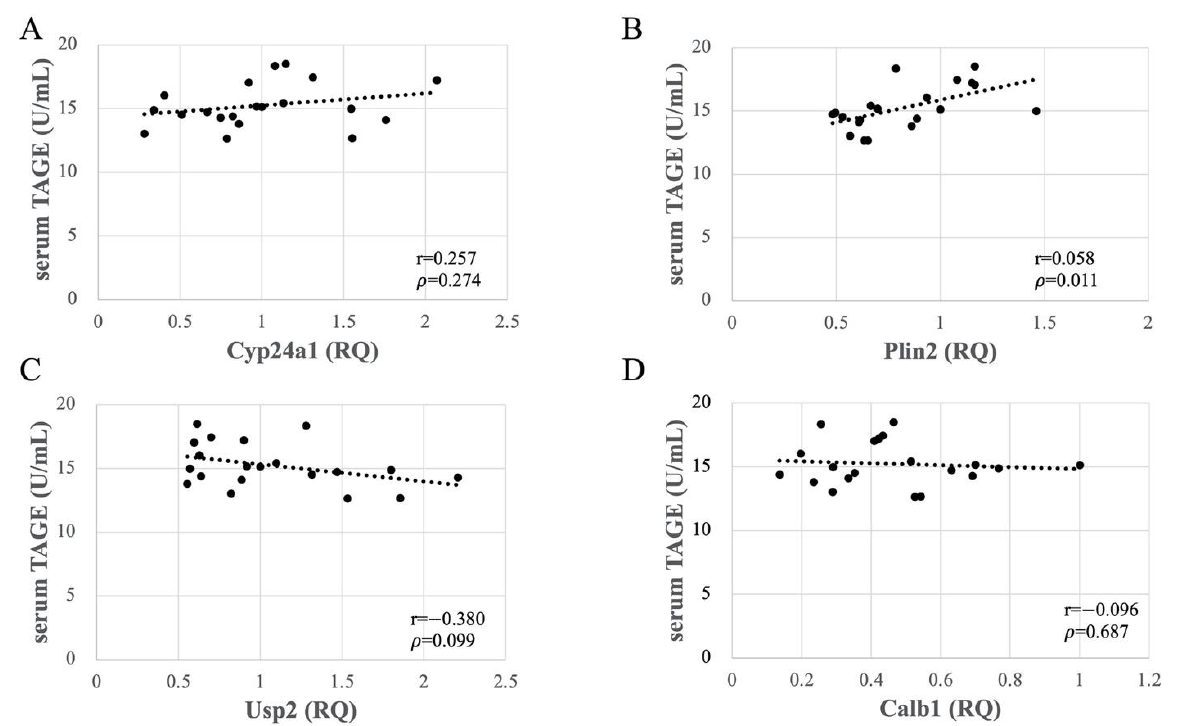
Figure 5. Relationships between serum toxic advanced glycation end-products (TAGE) concentrations and expression levels of Cyp24a ( A ), Plin2 ( B ), Usp2 ( C ), and Calb1 ( D ) in Wistar rat kidneys. RQ, relative quantification by real-time polymerase chain reaction ( n = 10 per group).